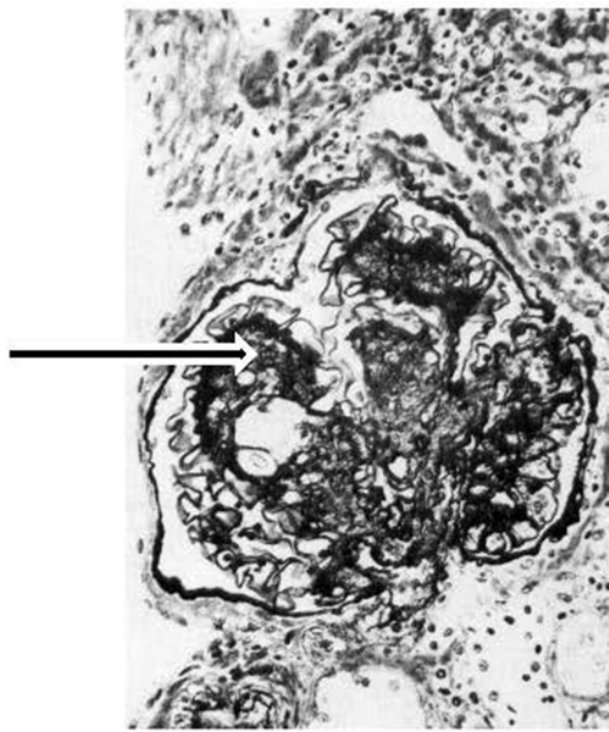
Figure 5. Advanced mesangial proliferation in callitrichid IgM nephropathy (arrow). Movat, 250 ×